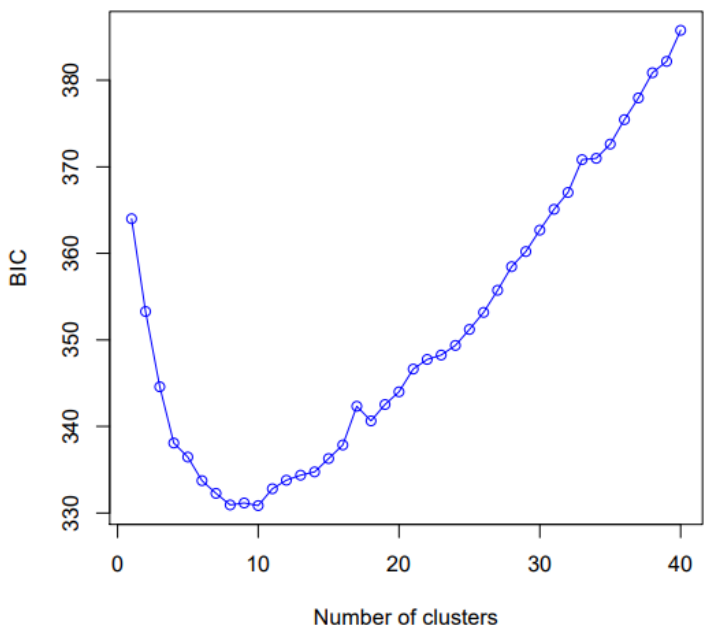
Figure 8. Value of Bayesian information criterion (BIC) versus number of clusters. This graph shows a clear decrease of BIC until k = 10 clusters; after which, BIC increases.